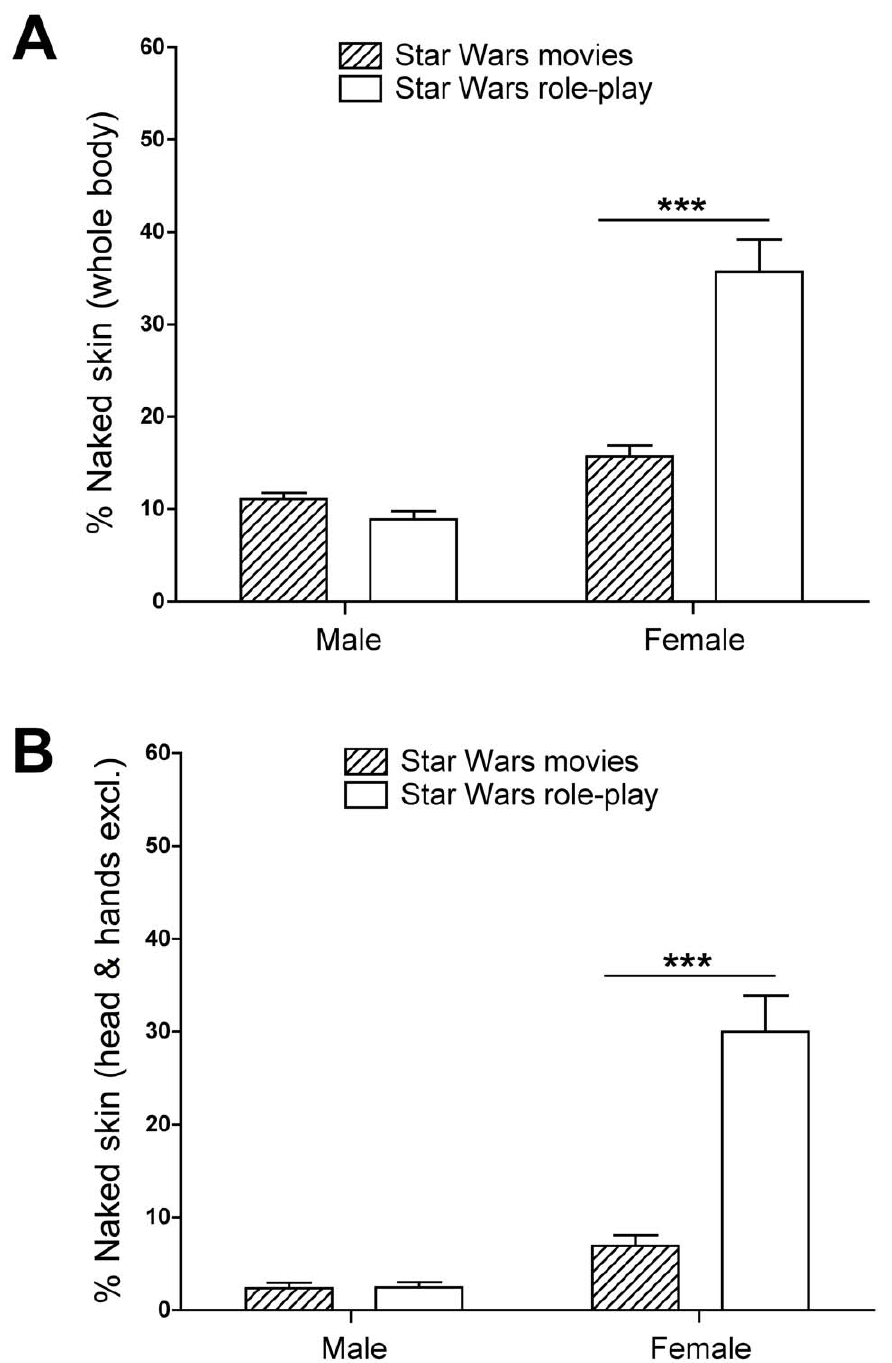
Figure 5. Influence of explicit cultural norms on virtual skin disclosure. Shown is the percentage of exposed skin in relation to the area of the entire body (A) and of the body excluding the head and hands (B) for avatars from the ‘‘Star Wars’’ role-play community and characters from the ‘‘Star Wars’’ movies. There was no difference between male avatars and movie characters, but female avatars revealed substantially more naked skin than female movie characters, despite being in a culturally constrained virtual setting. Results are presented as means 6 SEM. *** p ,